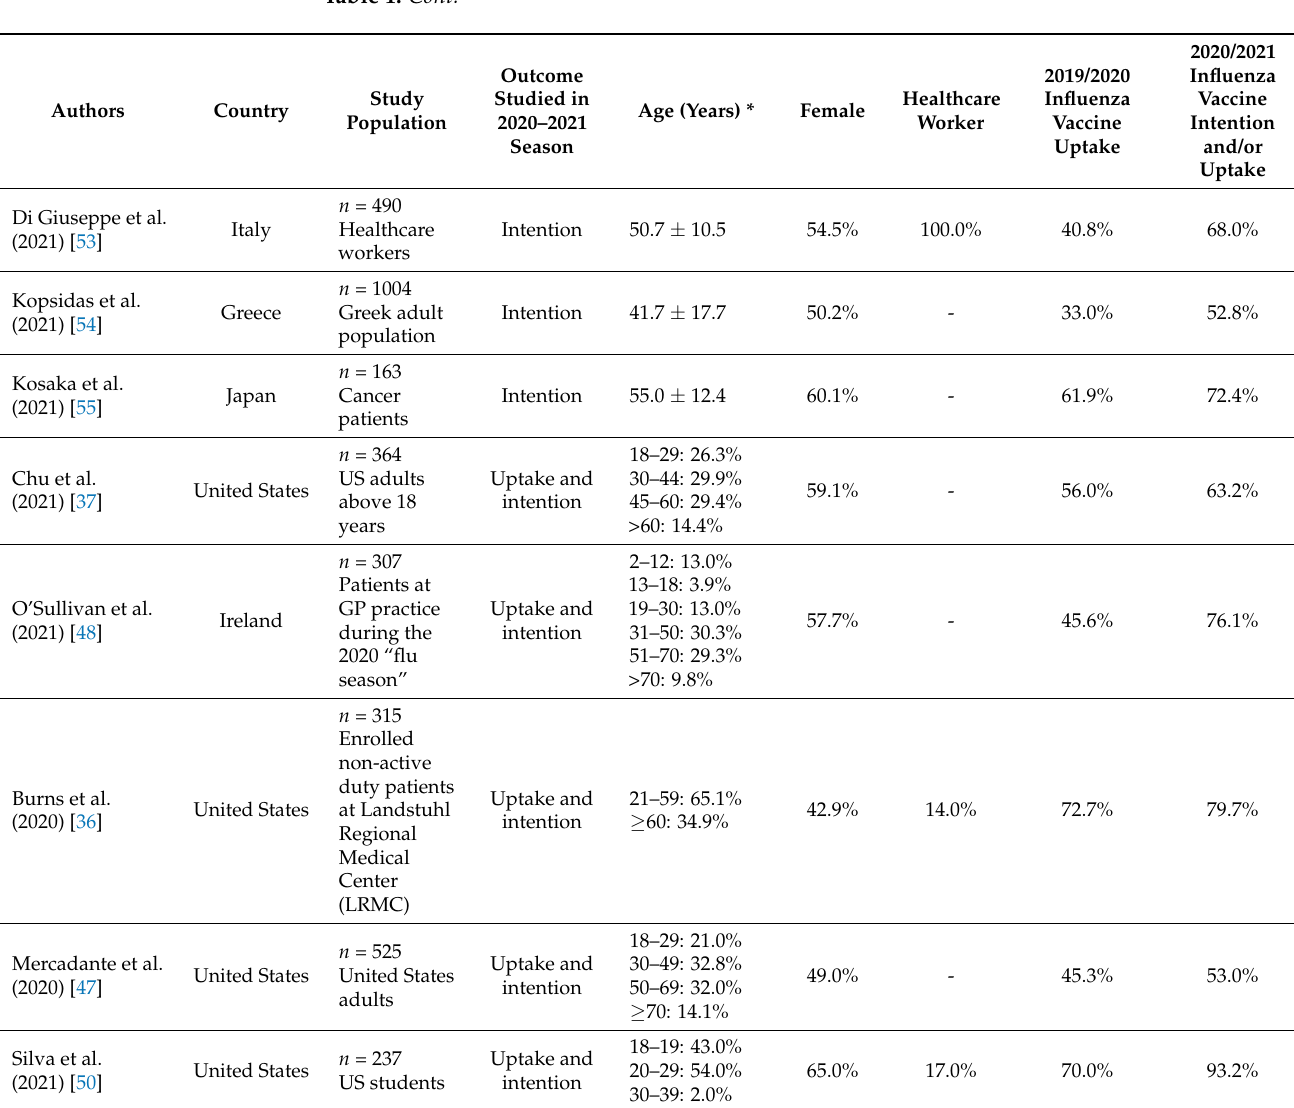
(Figure 2). The increase in vaccination intention was significantly higher in Asia and Europe, compared to North America ( p = 0.03) (Table